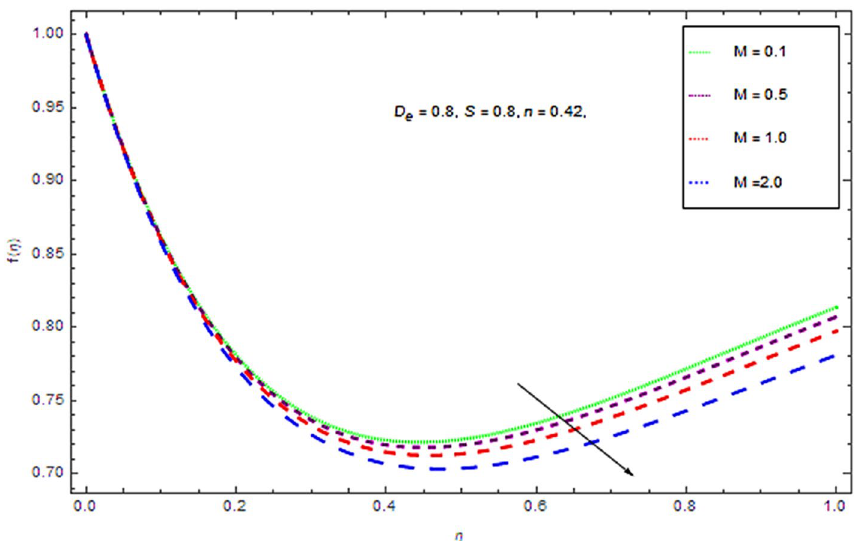
Figure 2. Influences of M on f (η) .